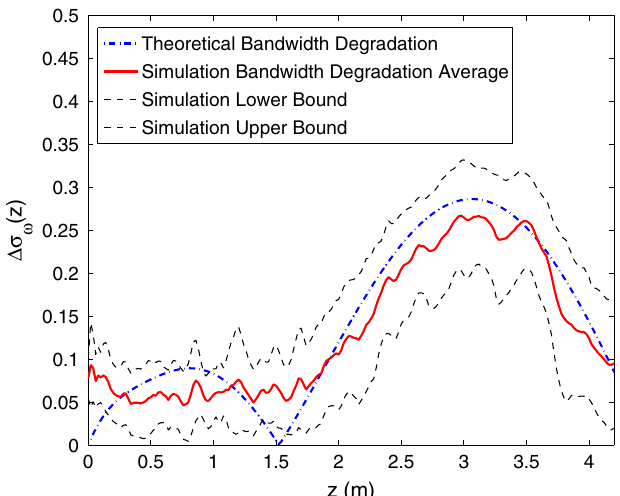
FIG. 4. (Color) Simulation and theory bandwidth degradation with multifrequency initial beam energy modulation. The beam ¼ ð 0 : 002 ; 0 : 04 ; 0 : 01 Þ ! 0 , energy modulation parameters are ! m ¼ ð 0 : 05 ; 0 : 1 ; 0 : 6 Þ . The simulation parameters are listed in (cid:13) m Table I. The red solid curve is the average of 20 simulation curves. The two black dashed boundary curves represent the simulation confidence intervals.